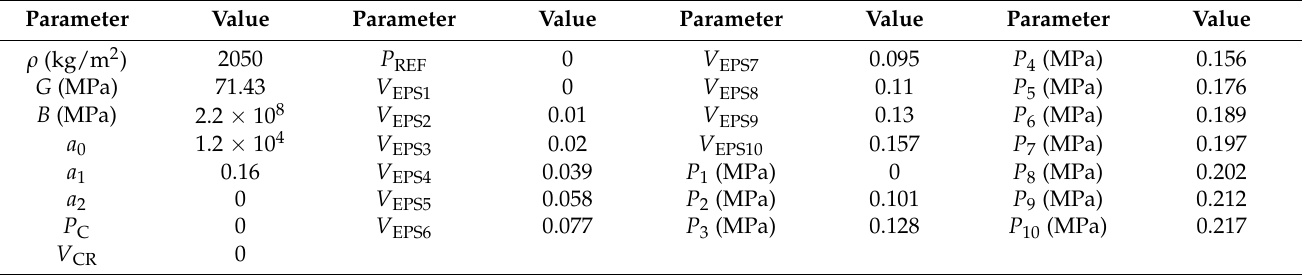
Table 5. Soil mass parameters [27].